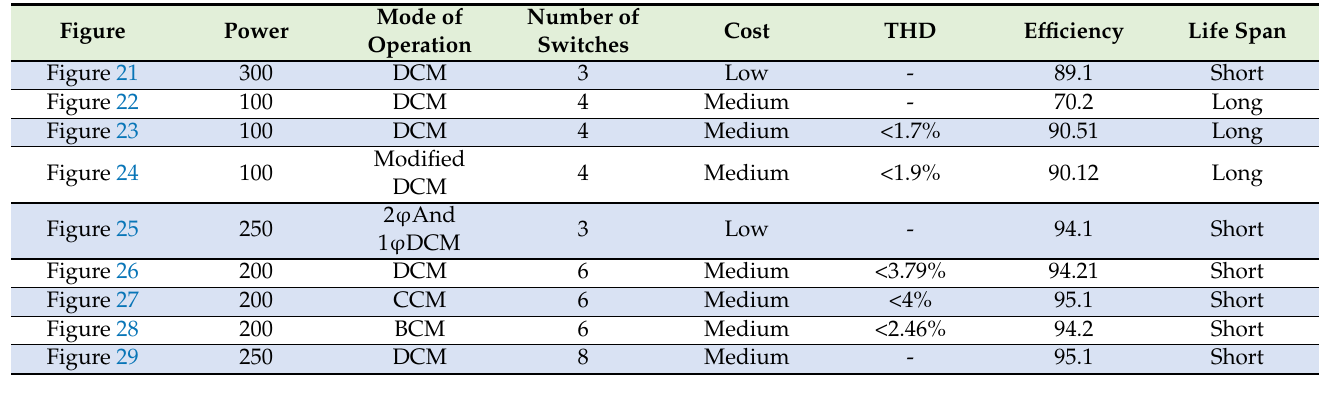
Figure 20. Single stage fly-back inverter. The performance of the single-stage isolated PV inverters is presented in Table 3. Table 3. Comparison of single-stage isolated PV inverter.